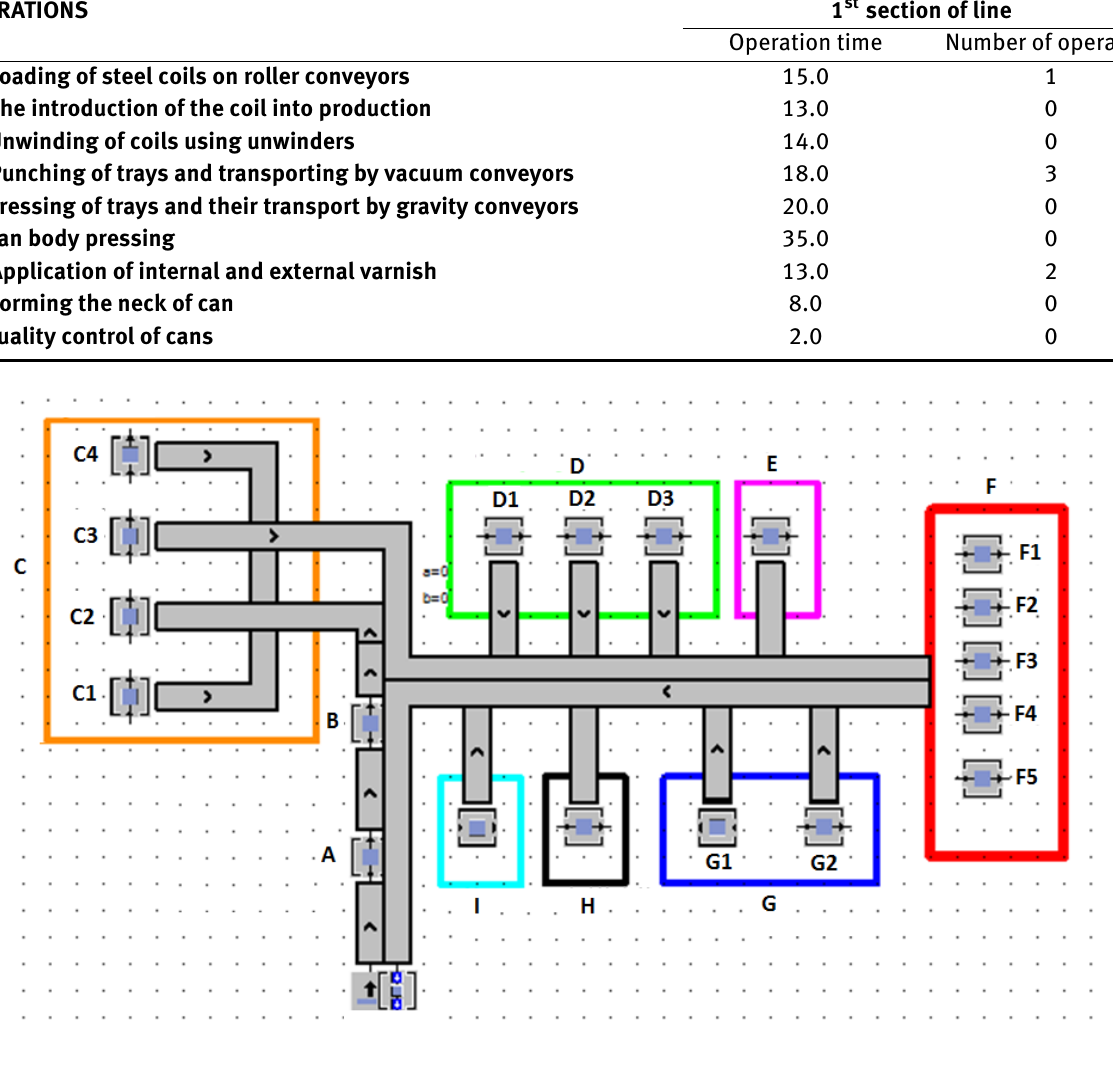
Figure 4: Simulation model of the line in